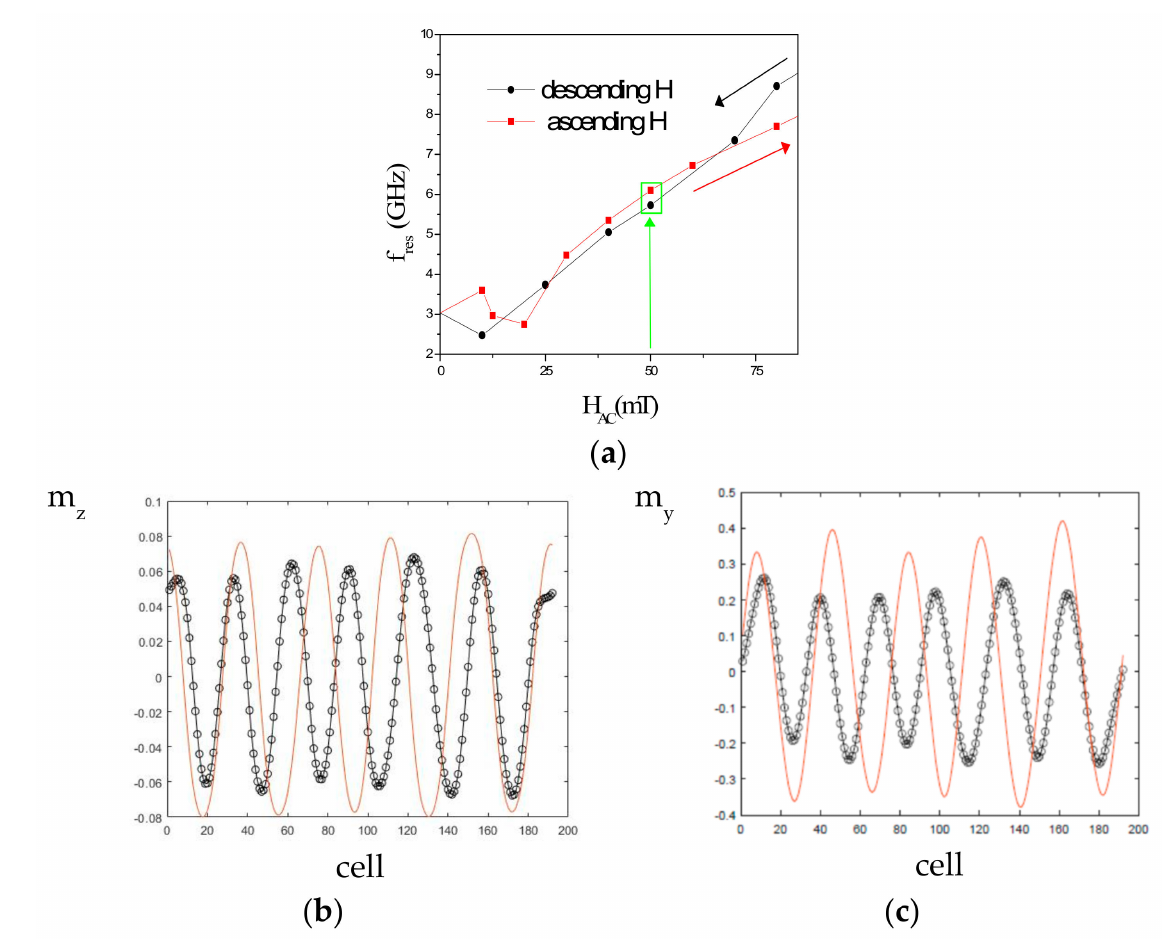
Figure 6. 65nm-NdCo x -(10nm-Al)-Py: ( a ) Permalloy ferromagnetic resonance (FMR) evolution versus external field, 1-D profiles of reduced magnetization components under 50 mT; ( b ) m z ; ( c ) m y profiles are extracted from the black dashed lines at Figure 3c,d. In all Figures, black (red) colors belong to the descending-H DC (ascending-H DC ) magnetic field branch of ( a